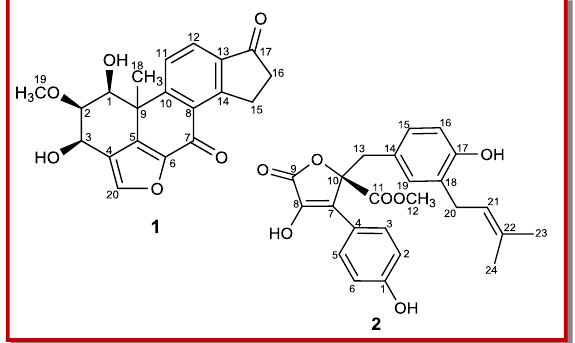
Figure 1: Chemical structures of 9-epi-viridol ( 1 ) and Butyro- lactone I ( 2